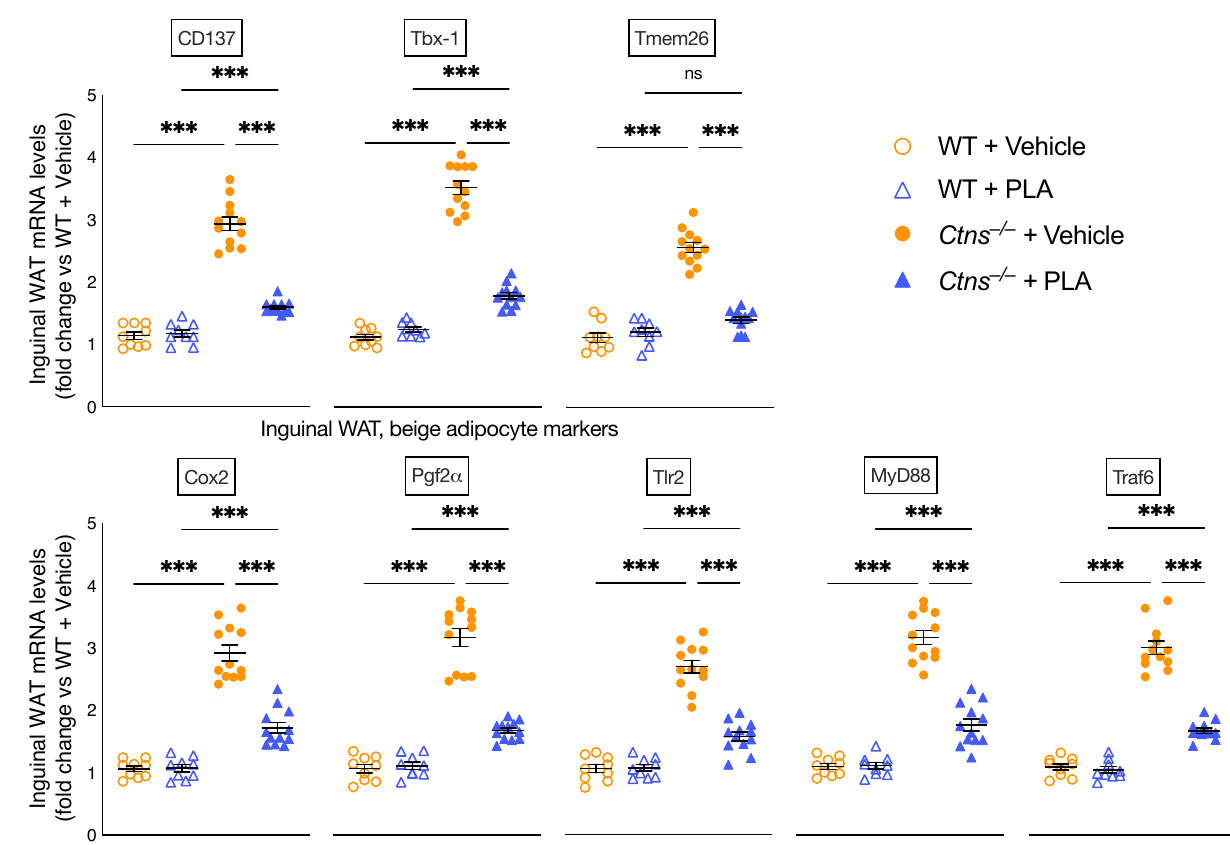
Figure 3. PLA attenuates adipose tissue browning in Ctns − / − mice. Gene expression of beige adipocyte markers (CD137, Tb-1 and Tmem26) in inguinal WAT was measured by qPCR. Gene expression of the Cox2 signaling pathway and toll like receptor pathway (Cox2, Pgf2 α , Tlr2, Myd88 and Traf6) in inguinal WAT was also measured. Final results were expressed in arbitrary units, with one unit being the mean level in vehicle-treated WT mice. In addition, results of PLA-treated Ctns − / − mice were compared to vehicle-treated Ctns − / − mice and specific p -values are shown above the bar. ns signifies not significant, *** p < 0.001.